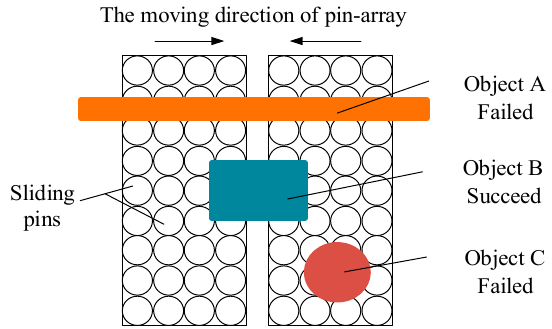
Figure 2. The objects that omnigripper can or cannot crawl.